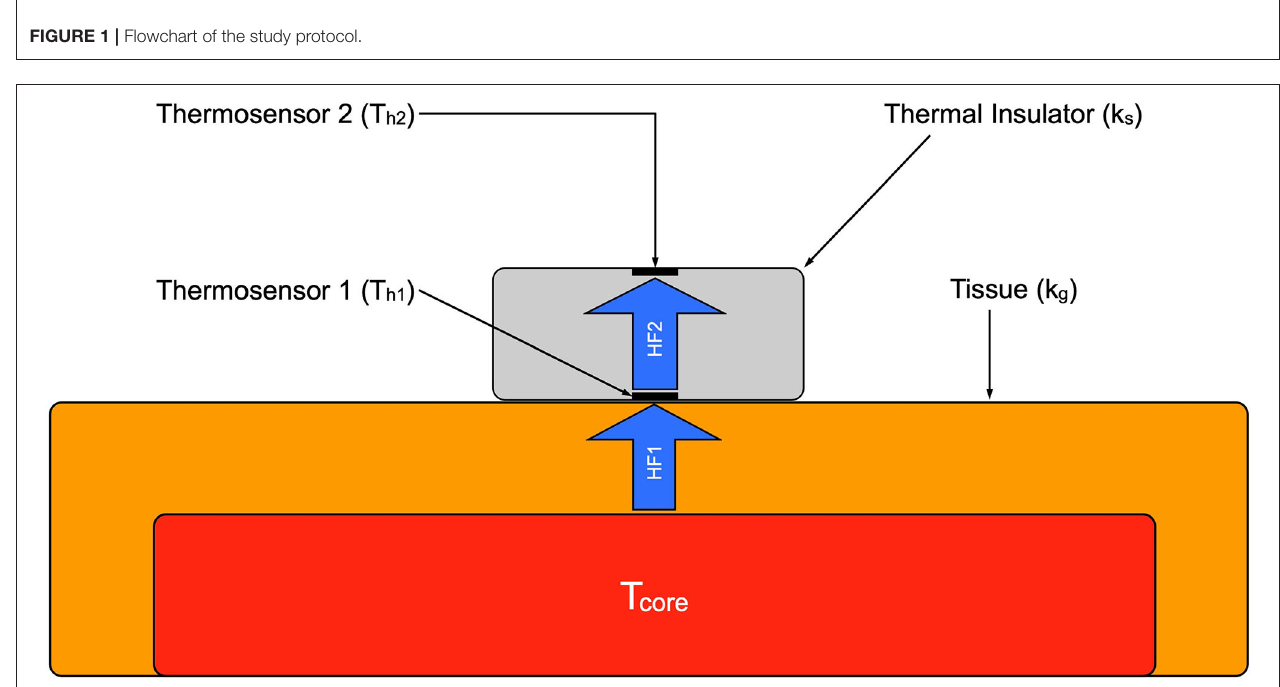
FIGURE 2 | Schematic of the double sensor. Tcore, core body temperature; HF 1, heat flux from body core to the sensor; HF 2, heat flux through the